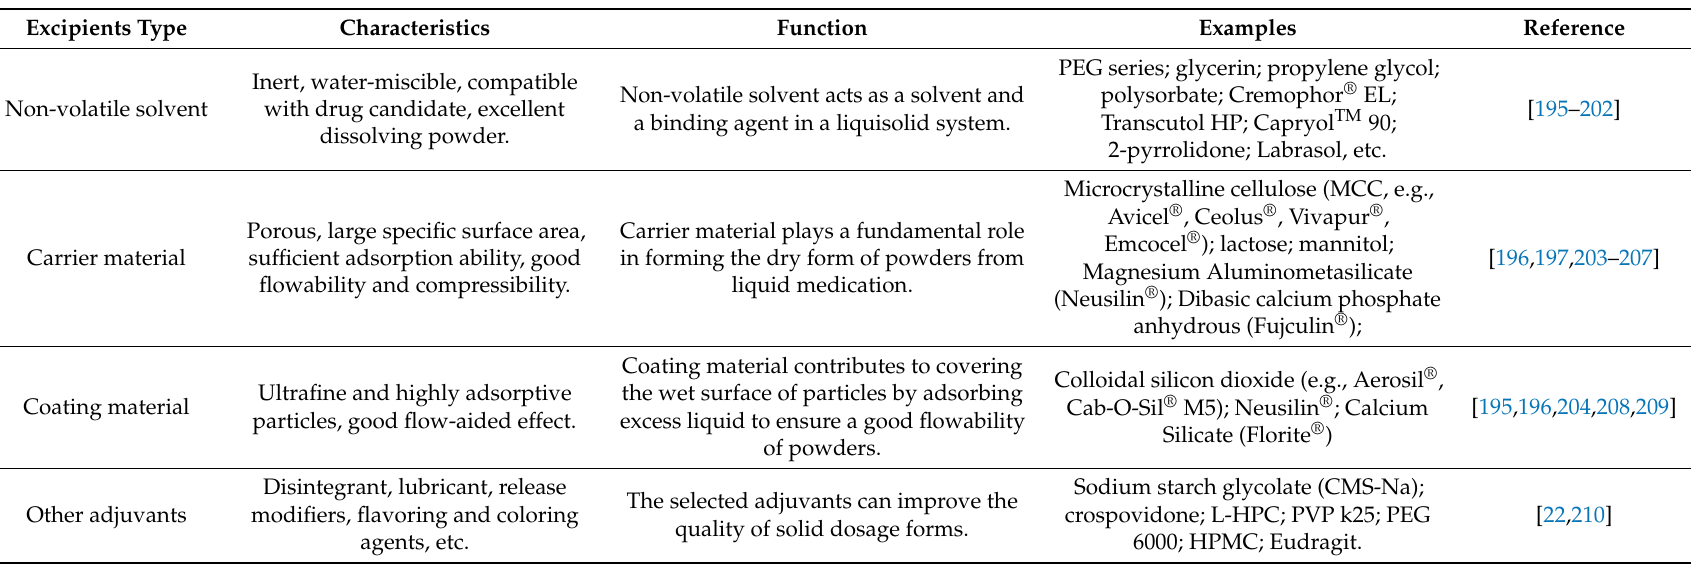
Table 3. Components generally involved in a liquisolid